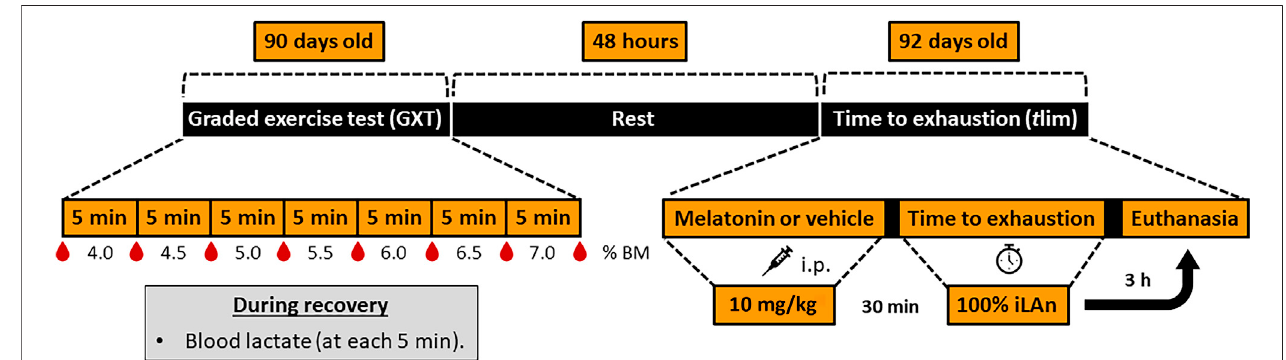
FIGURE 1 | Timeline of events of animals aged from 90 to 92 days old. After adaptation to aquatic environment procedures, at 90 days old all animals were subjectedtogradedexercisetest(GXT)todeterminetheintensityofexercisecorrespondingtotheindividualanaerobiclactacidemicthreshold(iLAn).DuringtheGXT,the stages were separated by 30-second intervals in which blood samples (25 µL) were collected. Afterwards, the animals were submitted to the swimming exercise with incrementsof0.5%ofbodymass(%BM)untilexhaustion.Forty-eighthourslater(restperiod),theanimalsreceivedmelatonin(MGandMEXG:10 mg/kg)orvehicle (CGandEXG:NaCl0.09%),andafter30 mintheratsfromEXGandMEXGweresubmittedtothetimetoexhaustiontest( t lim)at100%ofiLAn.After3 htheanimalswere euthanized. h, hours; min, minutes; i.p.,